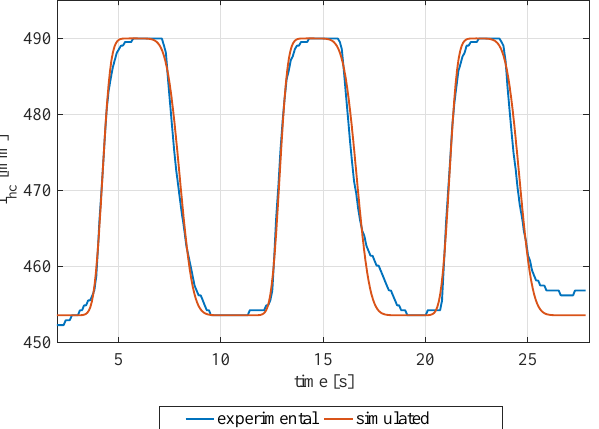
Figure 8. Reconstruction of the hydraulic lift cylinders extension during three manoeuvre repeti- tions.